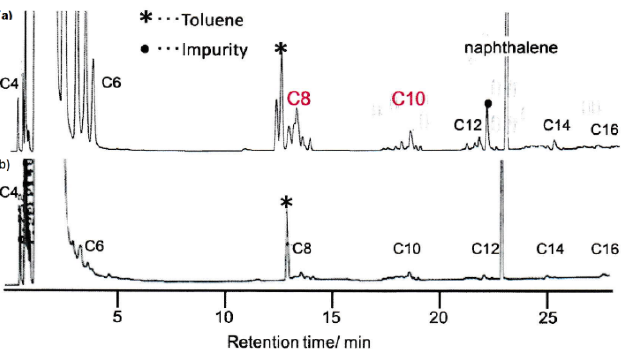
Figure 7. GC elution of the product. ( a ) Reaction of ethylene and 1-hexene catalyzed by NiBr 2 ( L1 ) − MMAO. ( b ) Reaction of ethylene catalyzed by NiBr 2 ( L1 ) − MMAO. Ni complex 0.010 mmol, [Al]/[Ni] = 300. Pentane 8 mL, 25 °C, 24 h.